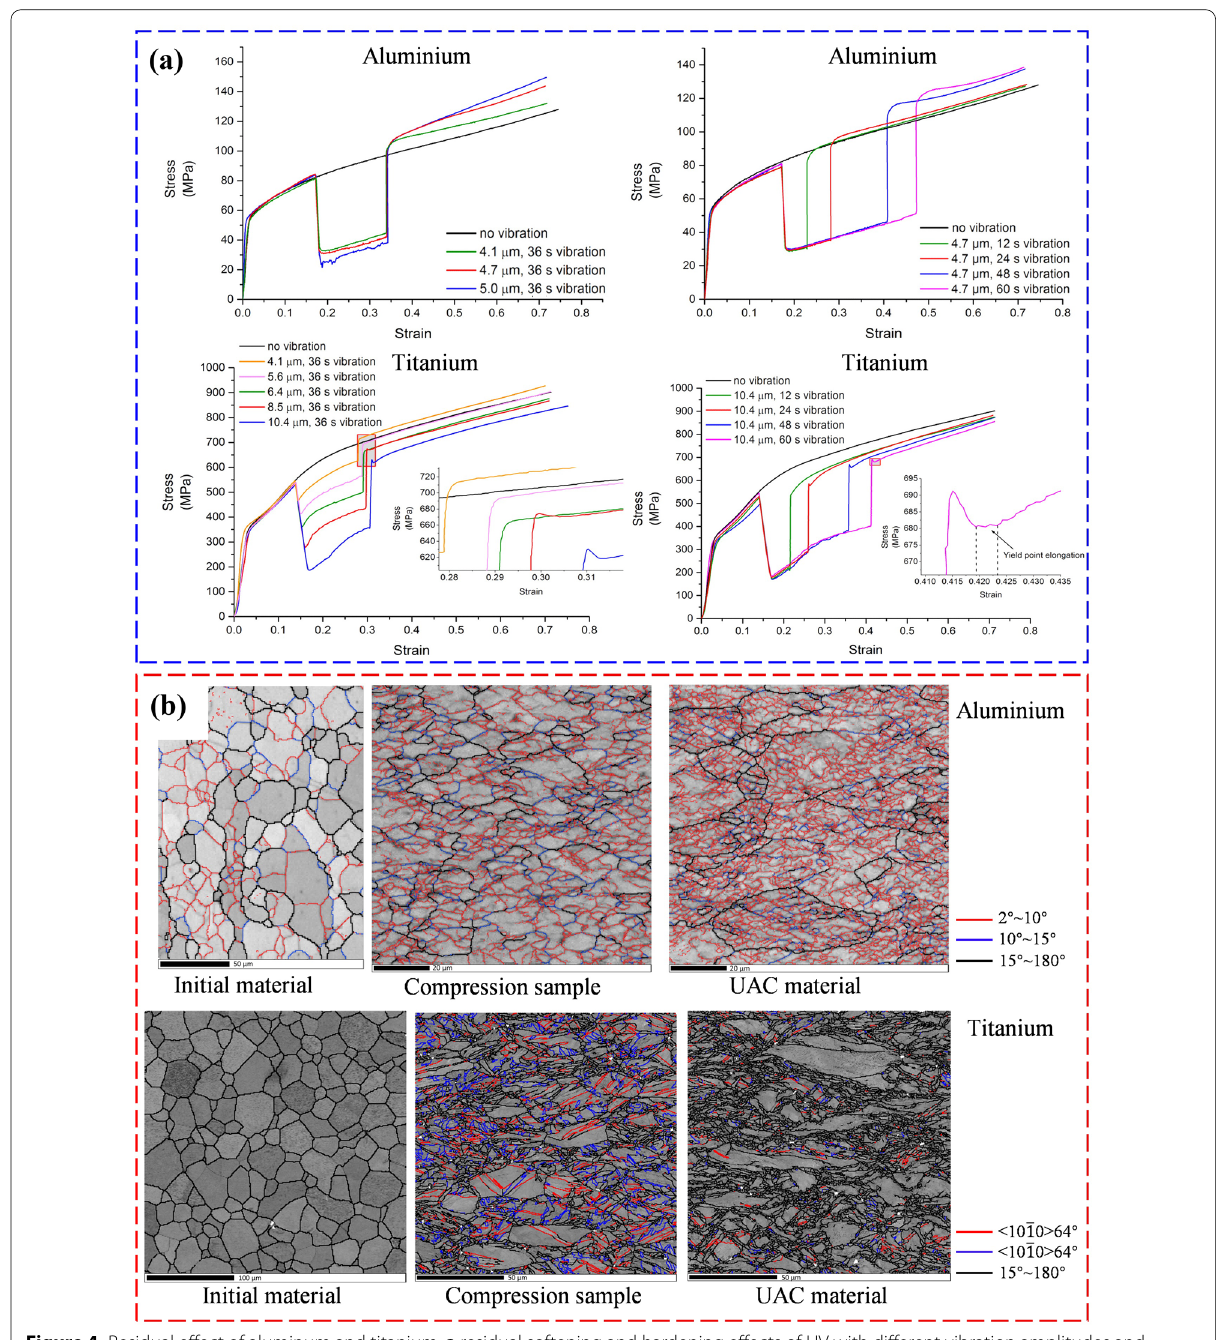
Figure 4 Residual effect of aluminum and titanium: a residual softening and hardening effects of UV with different vibration amplitudes and different vibration durations, b band contrast map with grain boundaries of aluminum and titanium